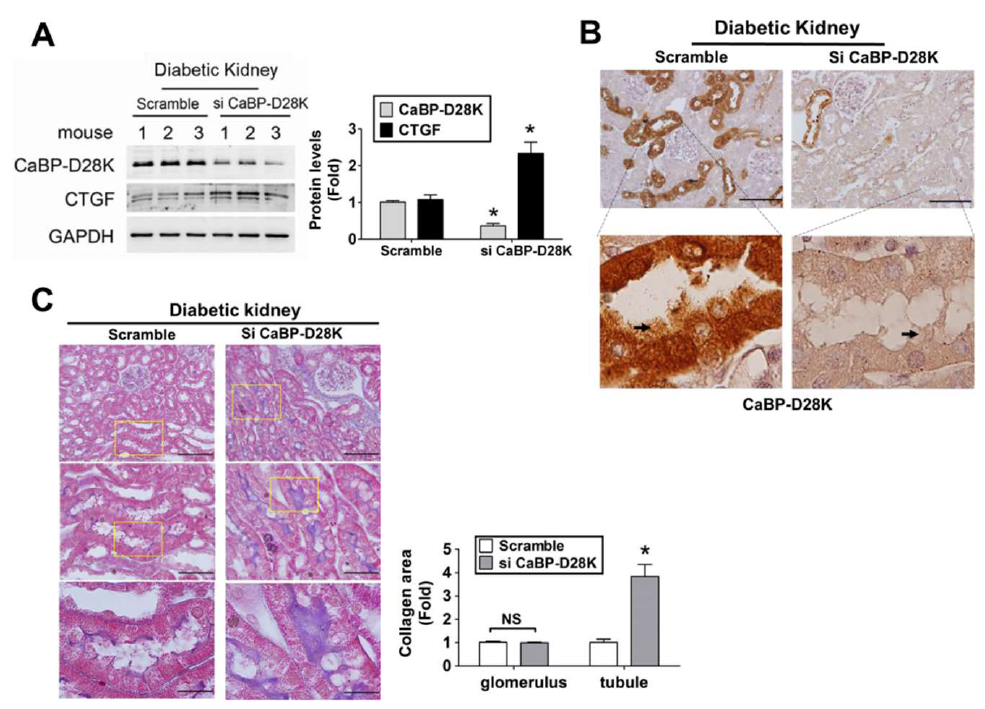
Figure 7. Calbindin-D28k siRNA in vivo injection increased renal fibrosis in the kidneys of db / db diabetic mice. ( A ) The protein expressions of calbindin-D28k and CTGF in the kidneys of control (scramble) diabetic mice and siRNA delivery diabetic mice were determined by Western blotting. Three representative mice per group were shown. Protein levels of immunoblotting were quantified by densitometry and normalized by GAPDH levels. Data were presented as means ± SEM (n = 6). * P < 0.05, siRNA versus control (scramble). ( B ) Immunohistochemical staining for calbindin-D28k in the kidneys of db / db diabetic mice without or with in vivo siRNA delivery. In lower panel, the arrow indicated the brush border of proximal tubule. ( C ) Masson’s Trichrome staining detected the renal fibrosis in si-calbindin-D28k and scramble injected diabetic mice. A panoramic view is displayed on the top panel and a magnification of the indicated region is displayed on the middle and bottom panel. Upper panel: scale bar: 100 µ m; Middle panel: scale bar: 50 µ m; Lower panel: scale bar: 20 µ m. The semi-quantitative assessment of collagen levels with five random areas per section was determined by ImageJ software. Data are presented as means ± SEM (n ≥ 3). * P < 0.05, siRNA versus scramble control.